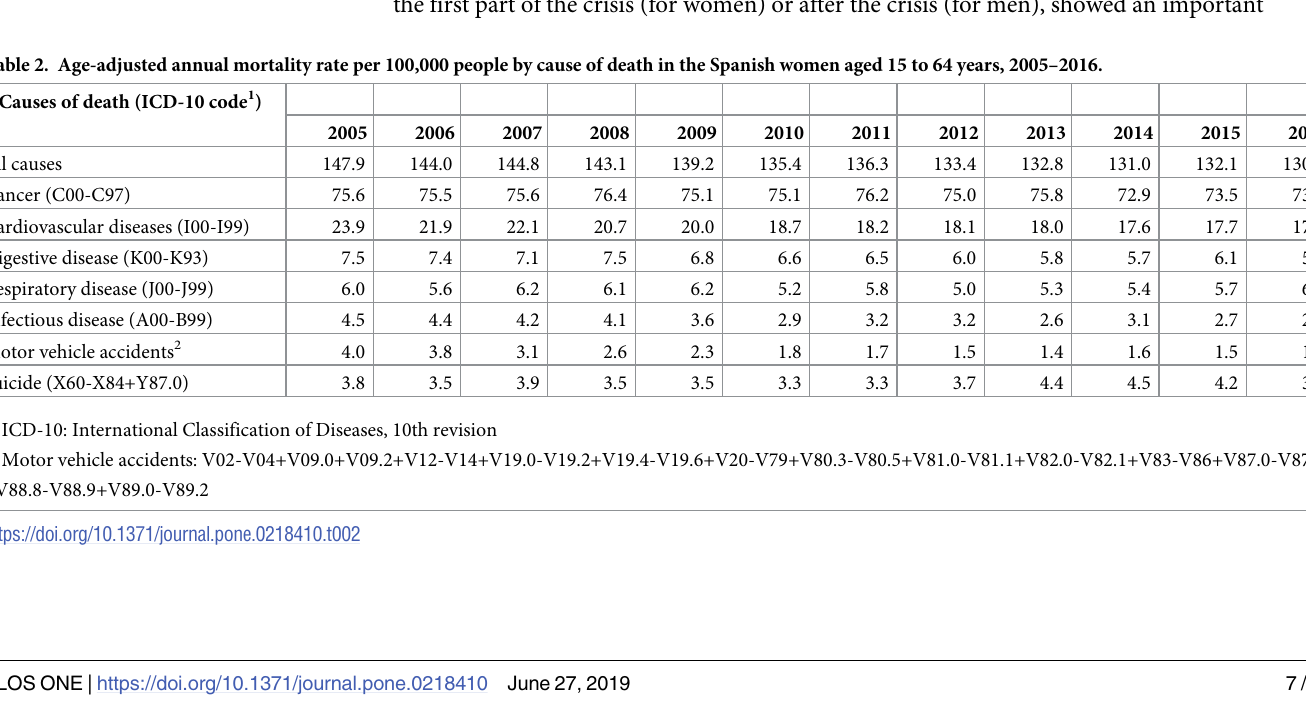
Fig 2. Mortality rate from respiratory diseases, infectious diseases, motor vehicle accidents, and suicide per 100,000 habitants. Men and women aged 15–64. Spain, 2005–2016.